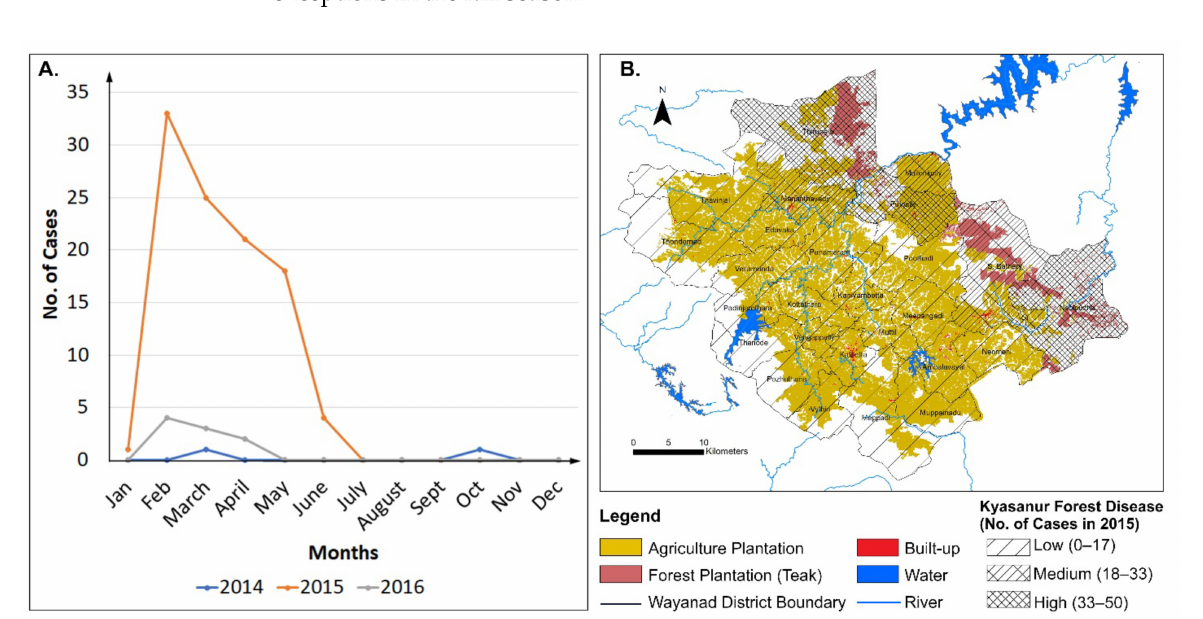
Figure 4. ( A ) Number of KFD cases in Wayanad for the year 2014, 2015 and 2016. ( B ) KFD cases in 2015 at Gram Panchayat level (rural administrative units) superimposed on a plantation map showing Correlation between LULCC and KFD